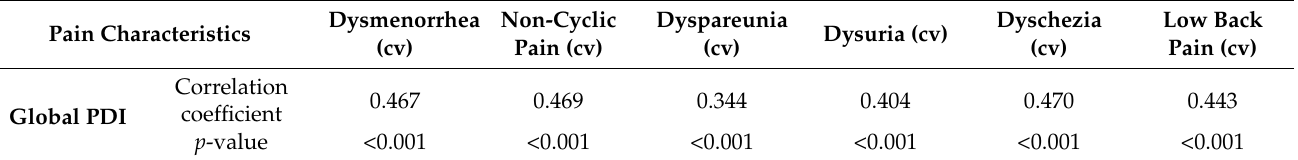
Table 2. Correlation analysis (Spearman’s Rho) between PDI and pain